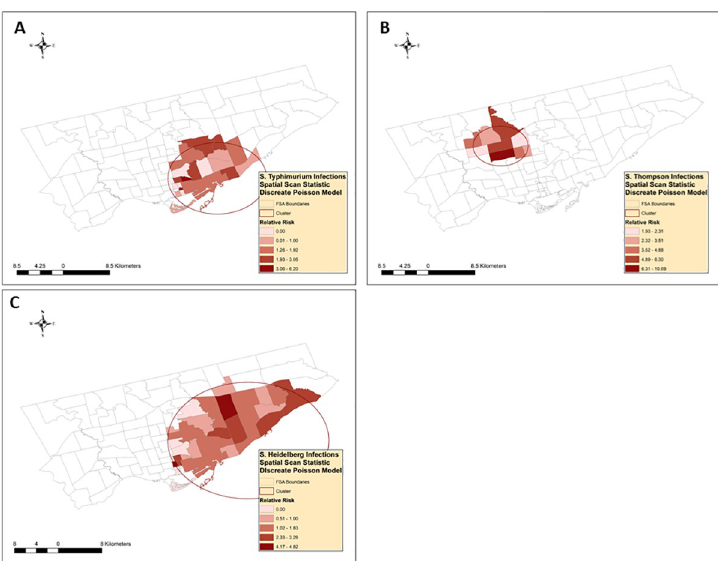
Fig 5. Spatial clusters of nontyphoidal Salmonella enterica infections with serotypes (A) Typhimurium, (B) Thompson, and (C) Heidelberg, identified by the scan statistic 1 . 1 Retrospective spatial analysis, scanning for clusters with high rates, using discrete Poisson models.